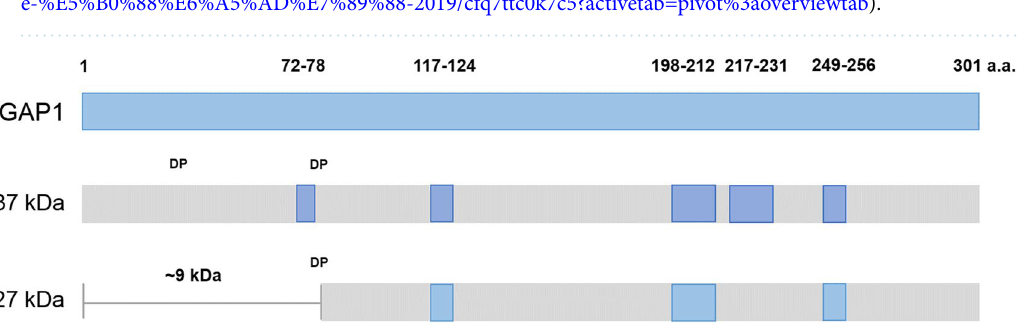
Figure 2. Microscopic photograph and SDS-PAGE analysis of protein crystals from the YNL culture filtrate at pH 5.44. ( a ) Microscopic photograph of the protein crystals. ( b ) SDS-PAGE analysis of the YNL culture filtrate at pH 5.44. Lanes M and 1 indicate the protein ladder and protein crystals, respectively. This image was edited by using Microsoft Office Professional 2019 PowerPoint (https:// www. micro soft. com/ zh- tw/ micro soft- 365/p/ offic